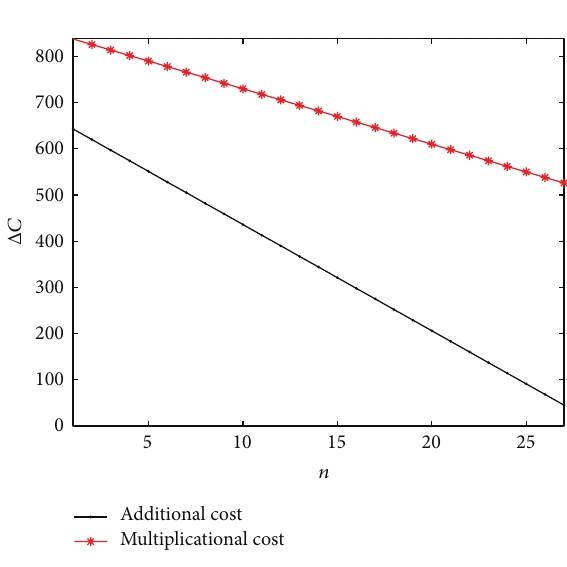
Figure 2: Error of computational